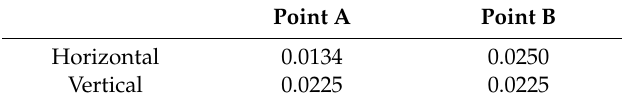
Table 5. Mean-squared errors of displacements for shock absorber function (13) (mm 2